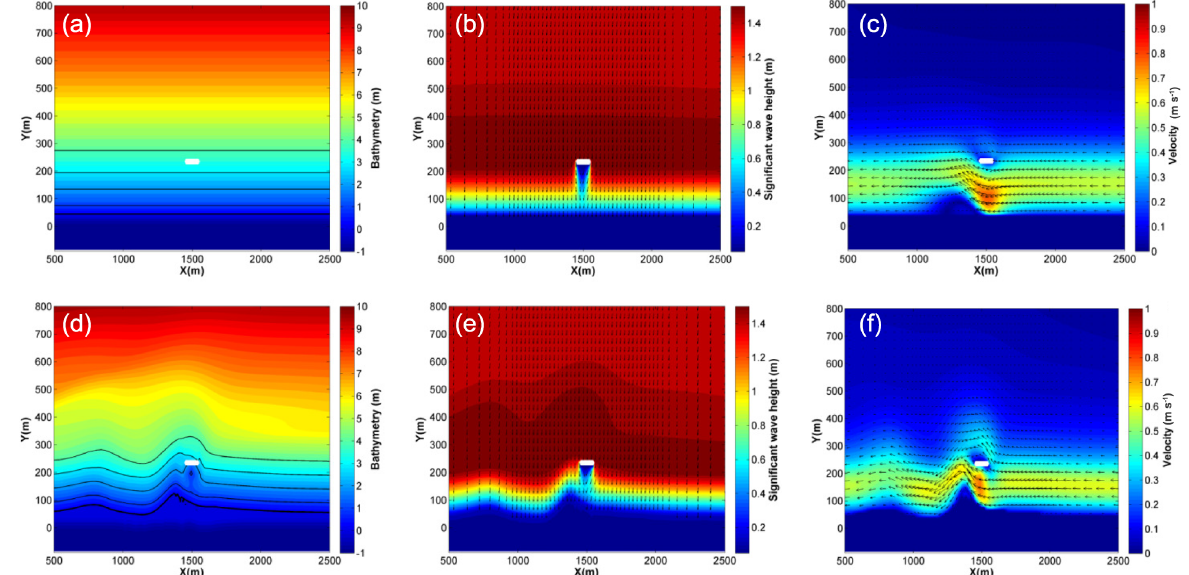
Figure 3. Model results for the breakwater’s length-to-distance ratio of 0.5. Bathymetry (a, d) , waves (b, e) , and currents (c, f) for the initial condition (a, b, c) and near equilibrium (d, e, f) after 18 years. The thicker isoline in the bathymetry represents the shoreline, whereas the others represent the 1, 2, 3, and 4m